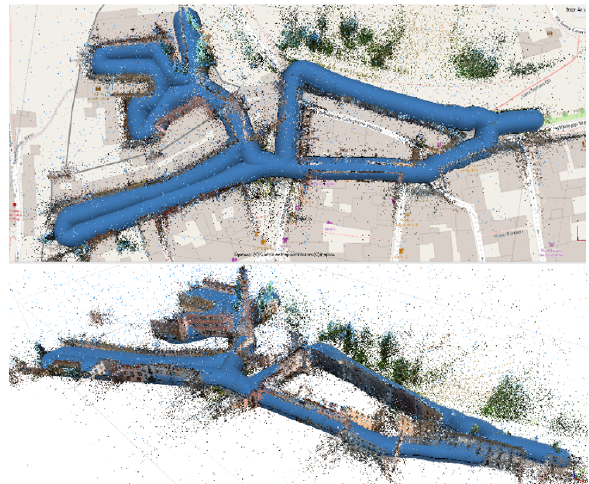
Figure 5: Orientation results of spherical 5k frames with the first